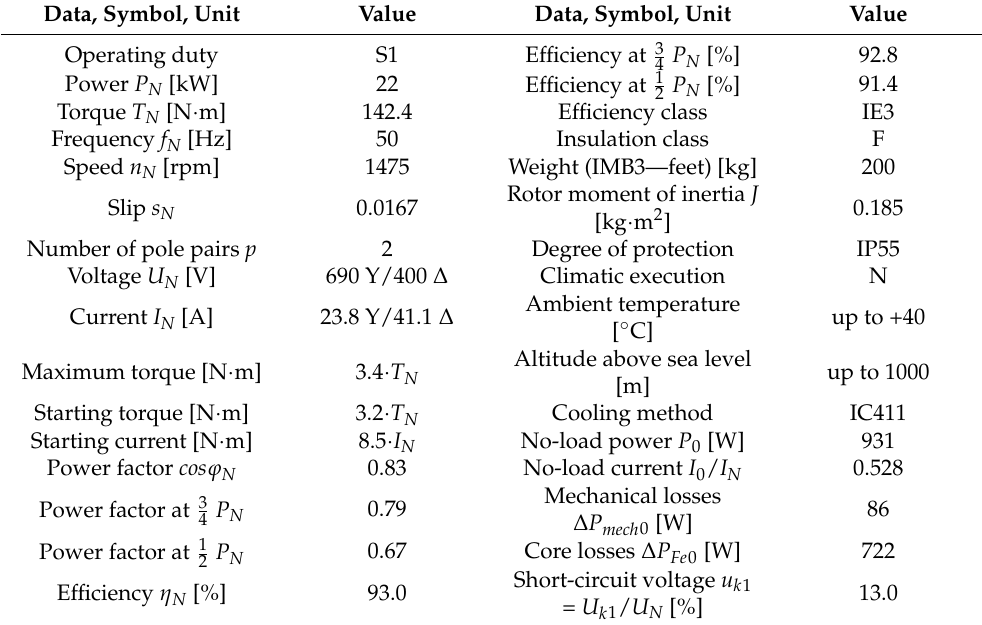
Table 1. Rated and cataloged data of the tested squirrel-cage